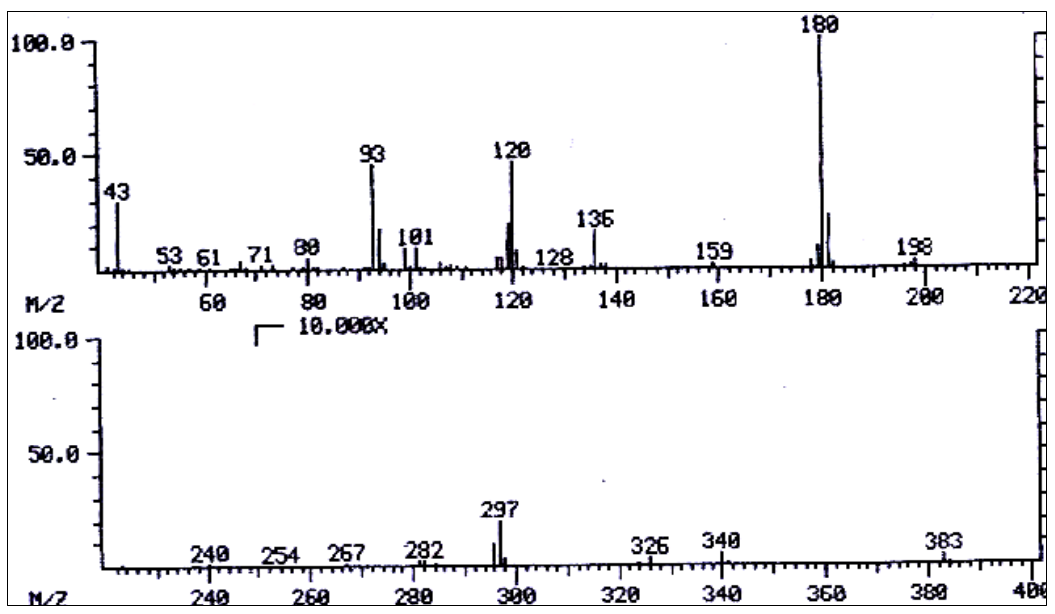
Figure 13. Mass spectrum of 3',7-diacetyllycopsamine/3',7-diacetyl intermedine/ 3',7-diacetyl indicine/3',7-diacetyl echinatine/3',7-diacetyl rinderine